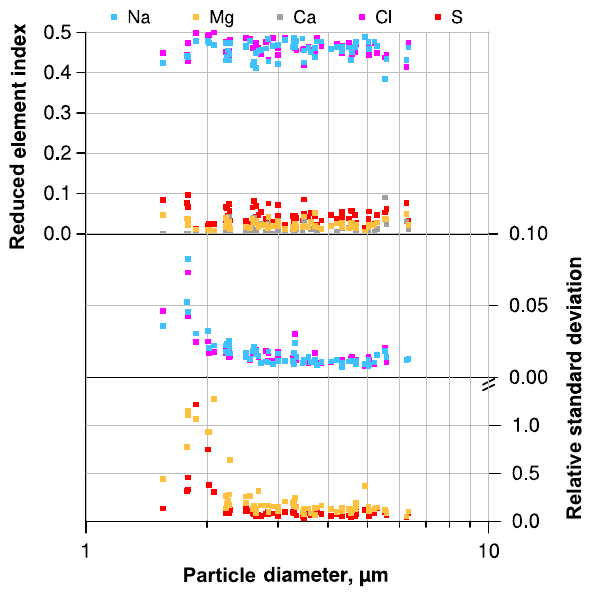
Figure 3. Mean element index only using Na, Mg, S, Cl and Ca for normalization, and according standard deviation (1 σ ) for NaCl- dominated particles from a typical atmospheric sample as function of particle size. Note that relative standard deviation for Ca is not shown due to frequent values below the detection